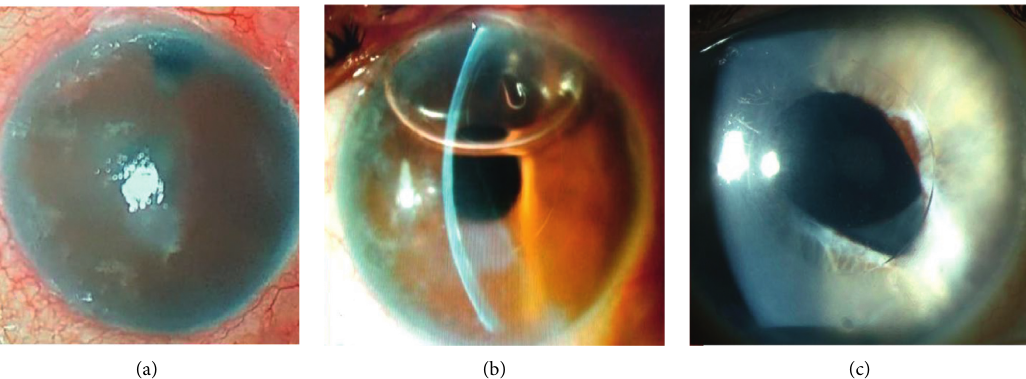
Figure 5: EndoArt ® device in the first-in-human trial: (a) corneal edema prior to implantation. (b) The same eye on the first postoperative day. Note the air bubble at the AC that works as a tamponade agent. (c) Another eye several weeks following implantation. The central area corresponding to the implant zone is transparent, whereas the periphery outside the implant borders is